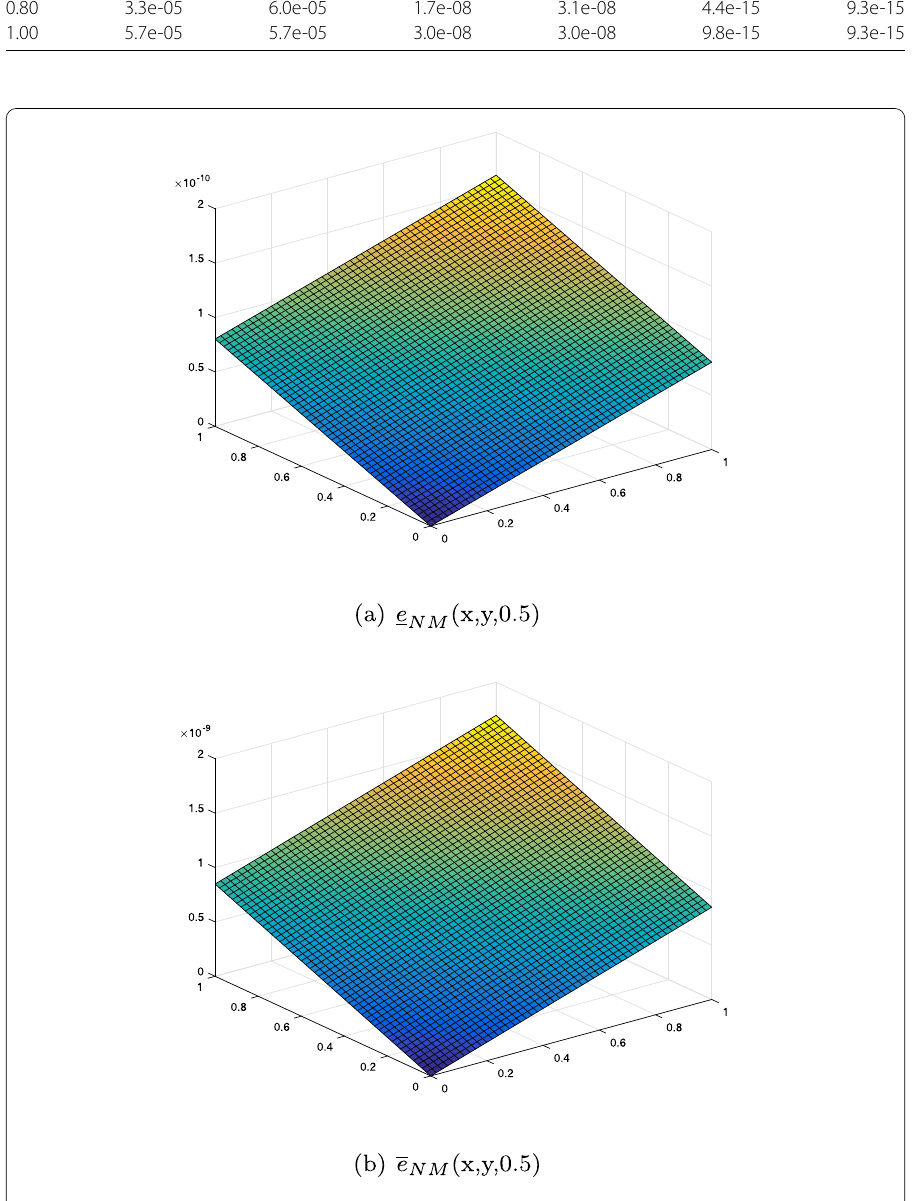
Figure 7 Numerical errors with N = 10 of Example